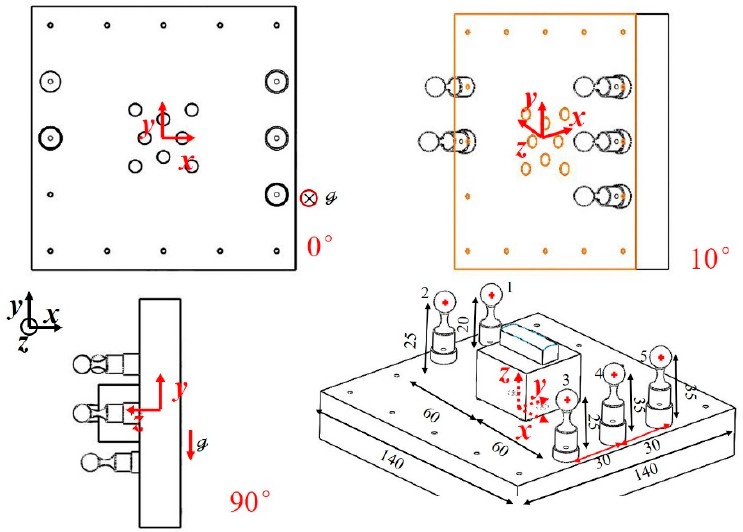
Figure 2. The five fiducials-aided 3D artefact measured in different positions.